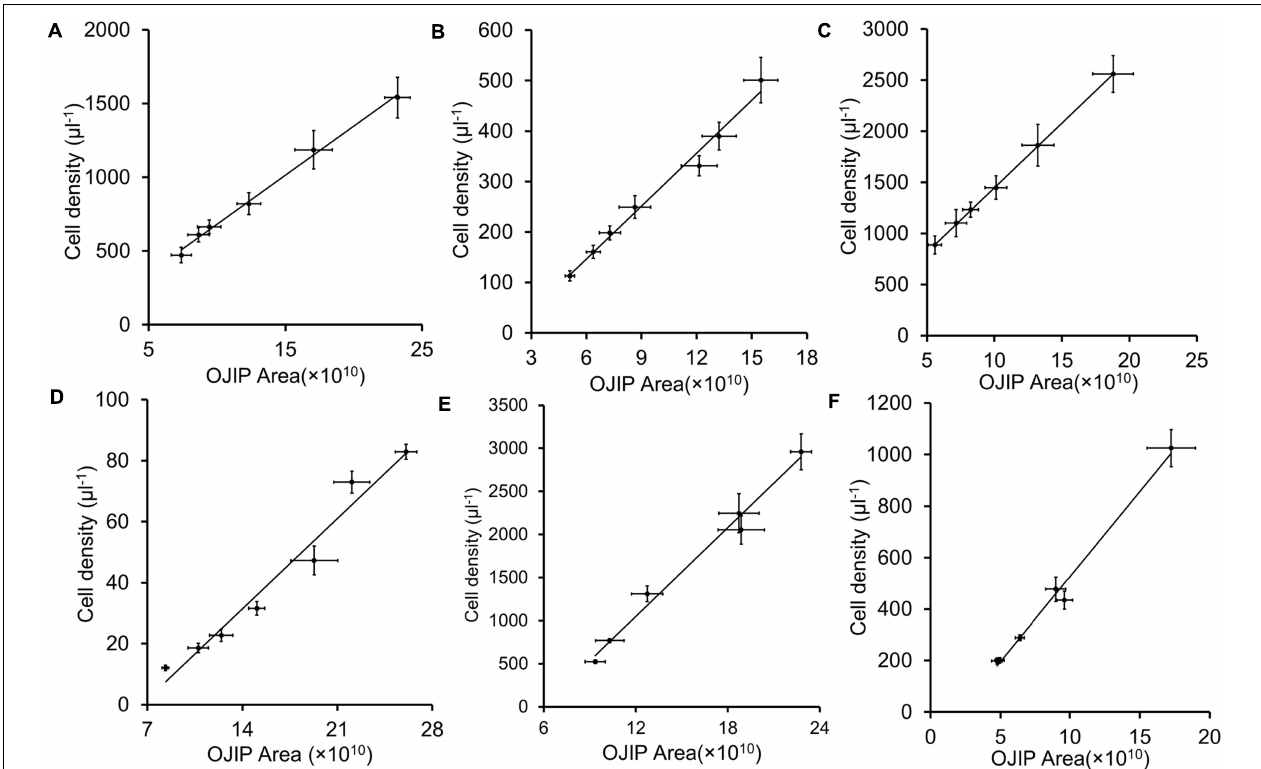
FIGURE 2 | The integral area of OJIP curve–cell density linear fits for five representative algal strains and their mixed culture. (A) Chlamydomonas reinhardtii CC 4533; (B) Chlamydomonas reinhardtii CC 125; (C) Chlorella sp. C2; (D) Synechococcus PCC 7942; (E) Synechocystis PCC 6803; (F) Mixed culture of five algal strains. Each point represents a sample from a different time point in each culture’s growth curve. TABLE 3 | The validation of using the integral area of the OJIP curve for determining the Chl a content and cell density in algae under pure culture. Algae strain Integral Calculated Chl a Measured Deviation Calculated cell Measured cell area content by Chl a density by measuring density (cell µ L − l ) ( × 10 10 ) measuring integral content integral area (cell µ L − l ) area (mg L − 1 ) (mg L − 1 )